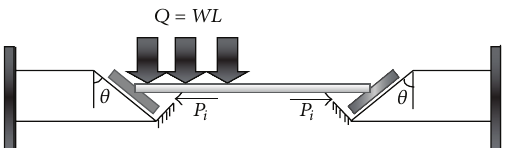
the beam tends to move upward to damp beam elongation.